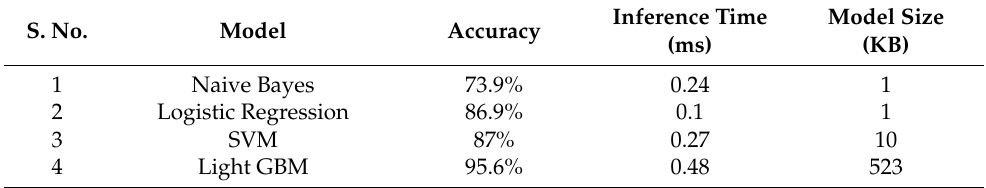
Table 3. Accuracy of the four models, inference time, and model size. ms = Milli seconds; KB = Kilo Bytes. S. No.